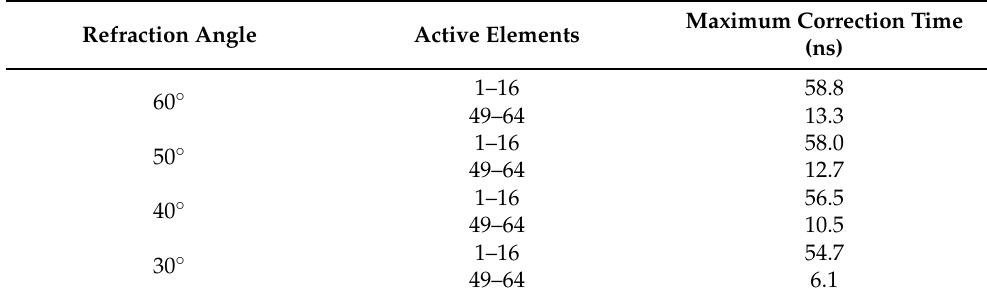
Table 4. Comparison of the maximum correction times of the Focal Laws when using the first 16 (1–16) and the last 16 (49–64) active elements of the phased array transducer for different refraction angles θ r .